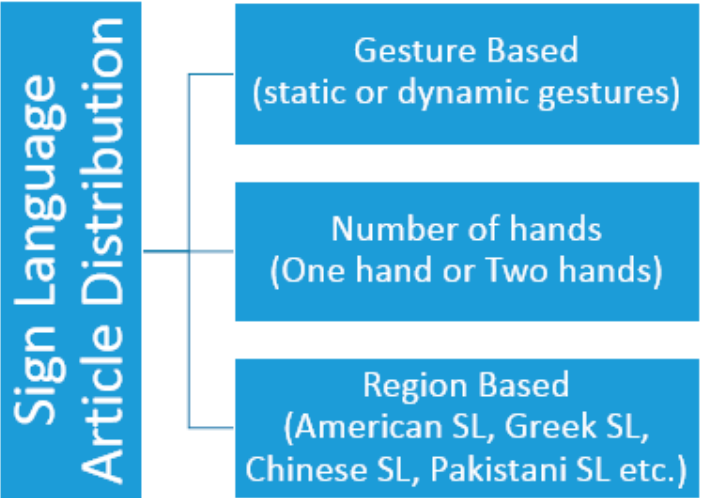
Figure 16. Article distribution based on region, gesture type, and number of hands used.